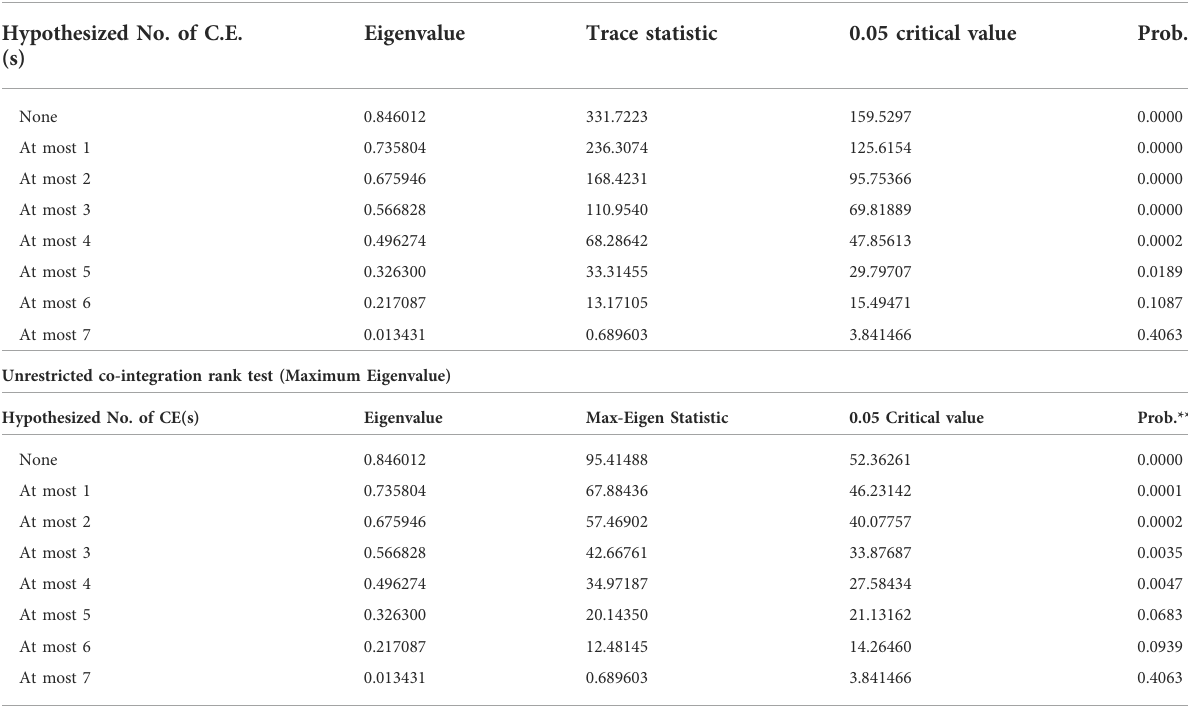
TABLE 7 Johansen co-integration test results. Unrestricted co-integration rank test (trace) Hypothesized No. of C.E.